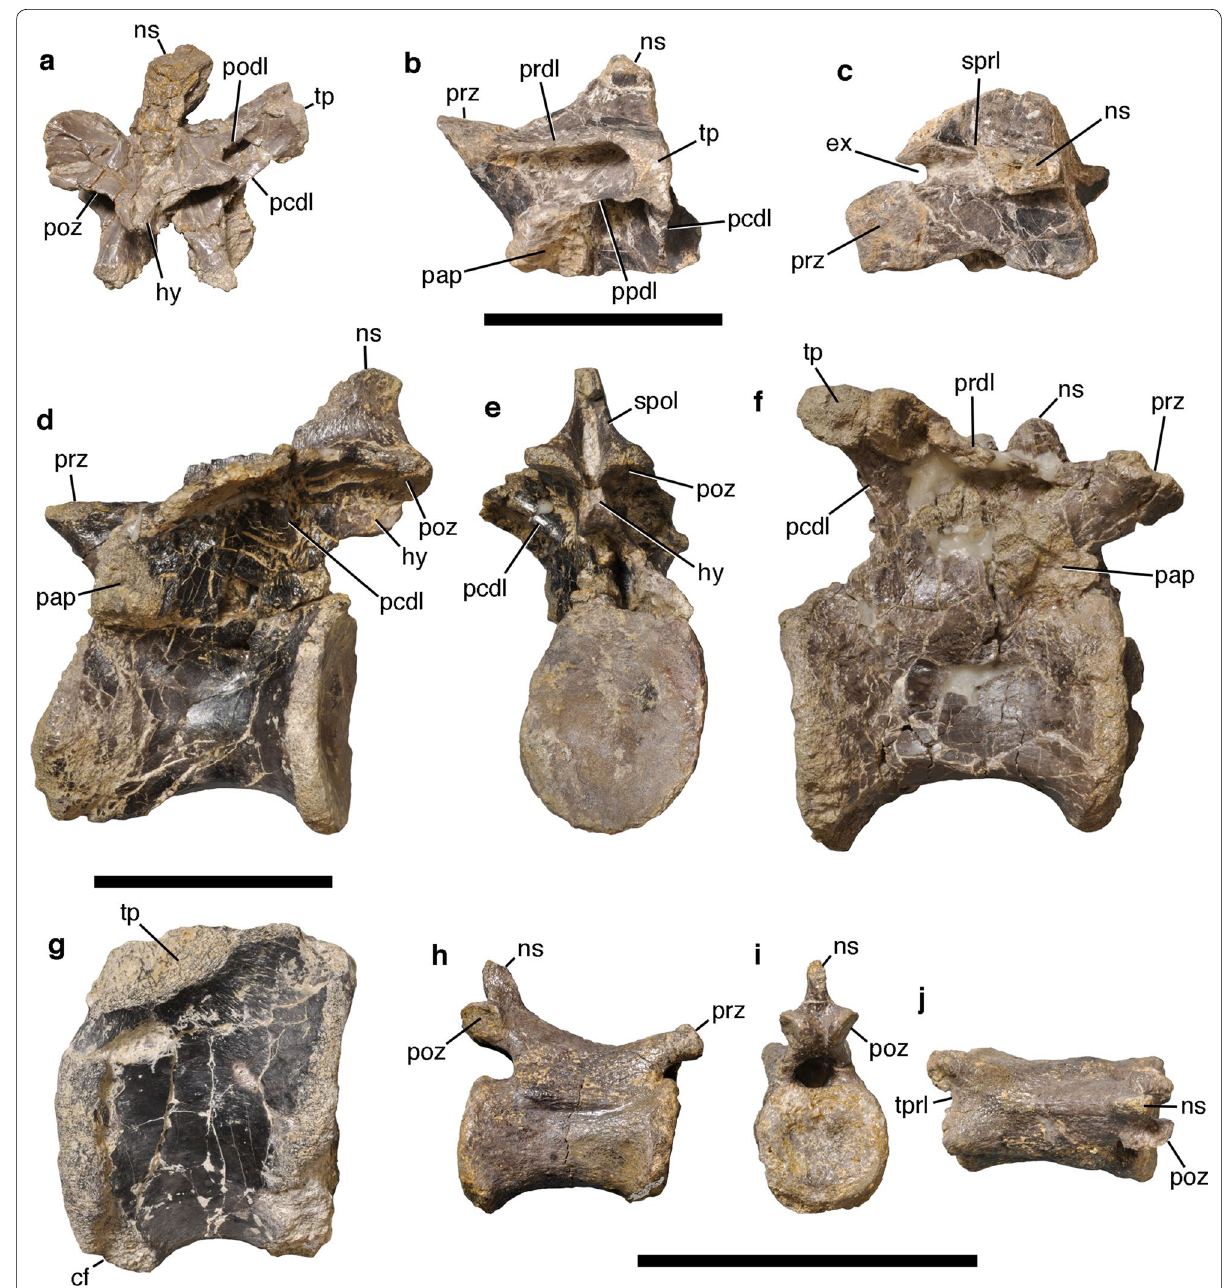
Fig. 14 Sauropodomorph vertebrae resulting from the recent excavation at Schleitheim-Santierge. a – c Anterior dorsal neural arch, MzA NAT15059, in posterior ( a ), left lateral ( b ) and dorsal ( c ) view; d , e mid-dorsal vertebra, MzA NAT15090, in left lateral ( d ) and posterior ( e ) view; f mid-dorsal vertebra, MzA NAT15095, in right lateral view; g anterior caudal vertebral centrum, MzA NAT15091, in right lateral view; h – j distal caudal vertebra, MzA NAT15097, in right lateral ( h ), posterior ( i ) and dorsal ( j ) view. cf, chevron facet; ex, prespinal expansion of intraprezygapophyseal slit; hy, hyposphene; ns, neural spine; pap, parapophysis; pcdl, posterior centrodiapophyseal lamina; podl, postzygodiapophyseal lamina; poz, postzygapophysis; ppdl, paradiapophyseal lamina; prdl, prezygodiapophyseal lamina; prz, prezygapophysis; spol, spinopostzygapophyseal lamina; sprl, spinoprezygapophyseal lamina; tp, transverse process; tprl, intraprezygapophyseal lamina. Scale bars equal 10